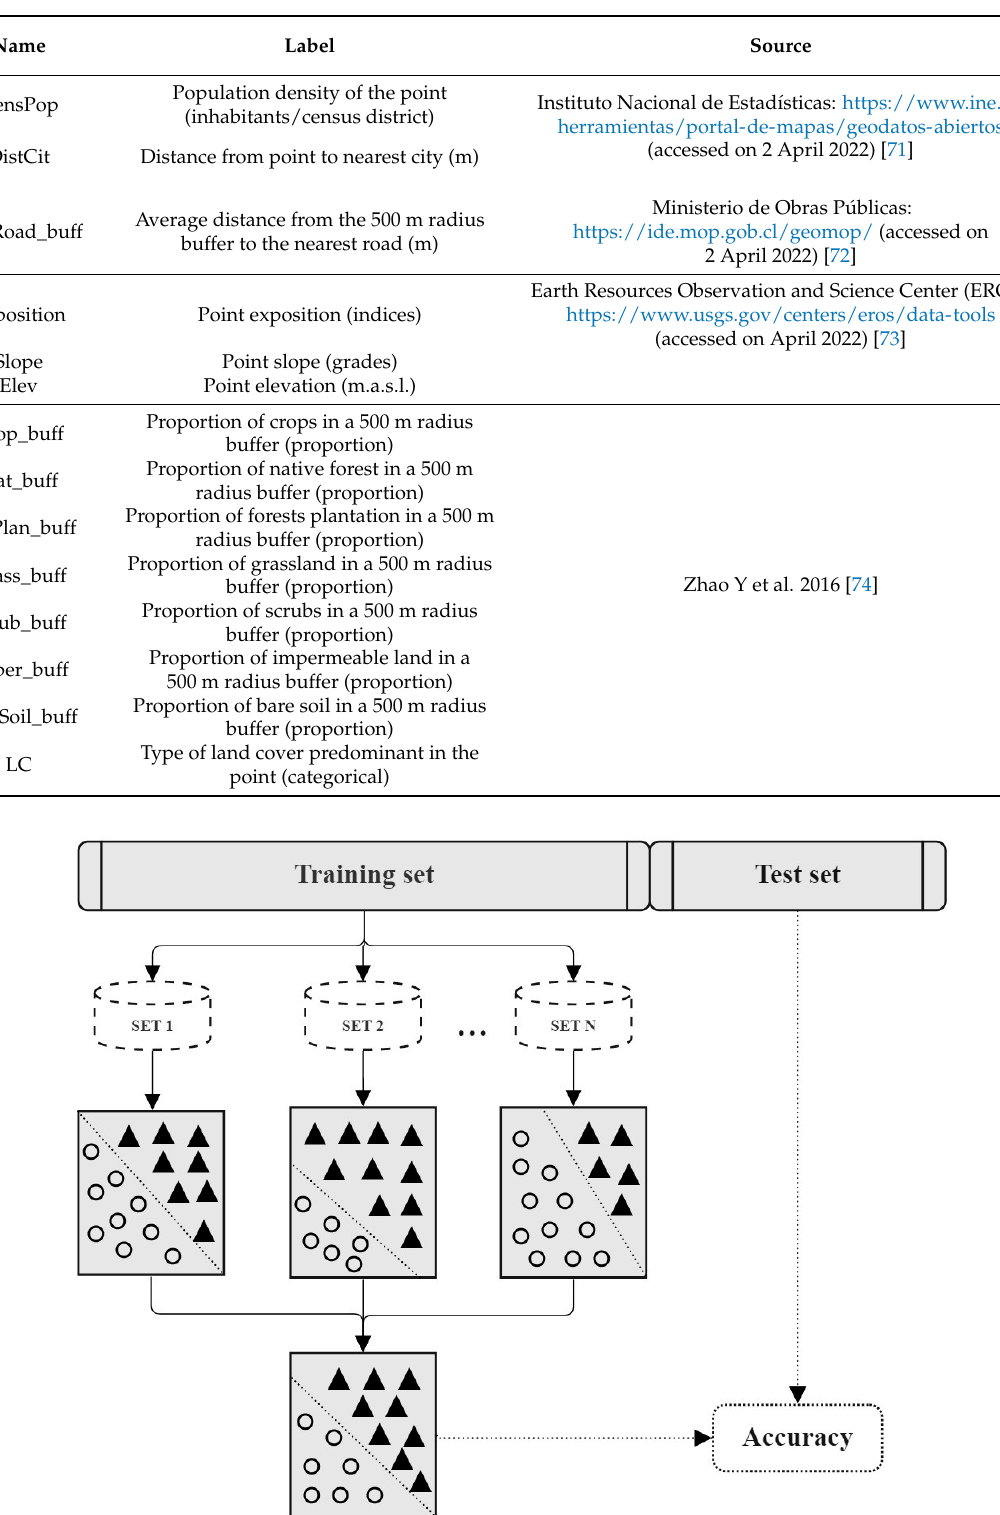
Table 1. Independent variables, names, and sources.